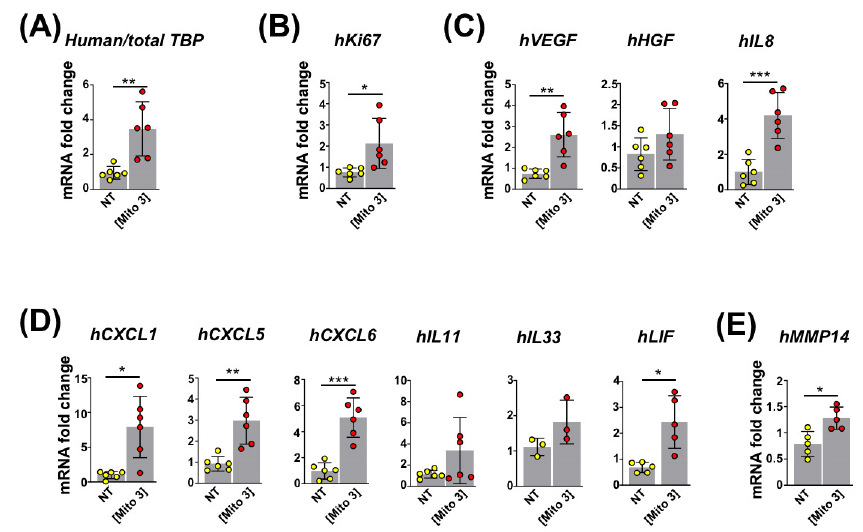
Figure 5. Cardiac mitochondria transfer improves the reparative functions of intramyocardially grafted MSCs. ( A – E ) MSCs were conditioned with cardiac mitochondria at the Mito 3 concentration 24 h prior to engraftment in mouse hearts. ( A ) Relative human/total TBP mRNA ratios in infarcted mouse myocardia at day 3 post-engraftment of cardiac mitochondria-preconditioned MSCs in reference to hearts injected with non-treated MSCs. ( B – E ) Relative human mRNA expression for ( B ) Ki67 ( n = 6); ( C ) VEGF , HG F, and IL8 ( n = 6); and ( D ) CXCL1 , CXCL 5, CXCL6 , IL11 , IL33 and LIF ( n ≥ 3) in infarcted mouse myocardia at day 3 post-engraftment of cardiac mitochondria-preconditioned MSCs in reference to hearts injected with non-treated MSCs. Unpaired Student’s t -test in ( A – E ) * p < 0.05, ** p < 0.01, *** p < 0.001. Each dot represents a mouse. Bar graphs represent mean values ± SD.